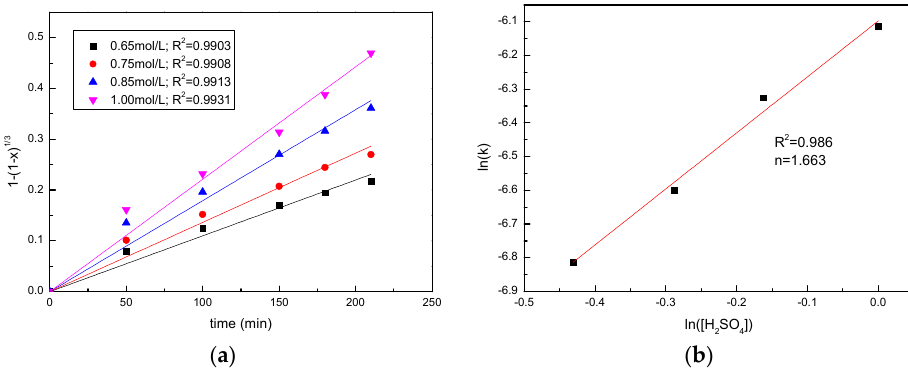
Figure 9. Analysis of reaction order with respect to H 2 SO 4 concentration ( a ) Plots of 1 − (1 − x ) 1/3 vs. time for manganese leaching at various sulfuric acid concentrations; ( b ) the determination of reaction order with respect to sulfuric acid concentration.